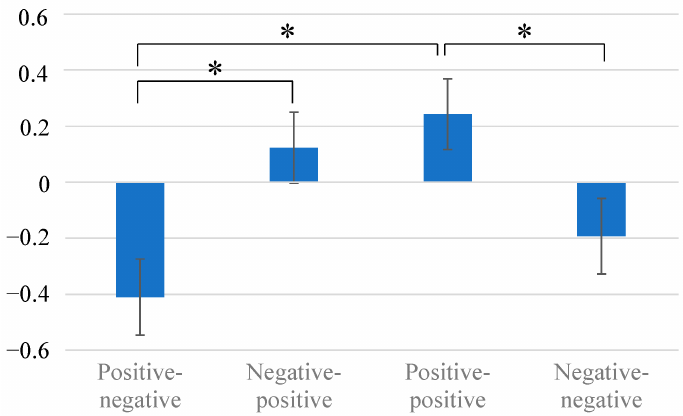
Figure 2. Average and S.E of attitude differences of before/after watching videos. * p < 0.05.